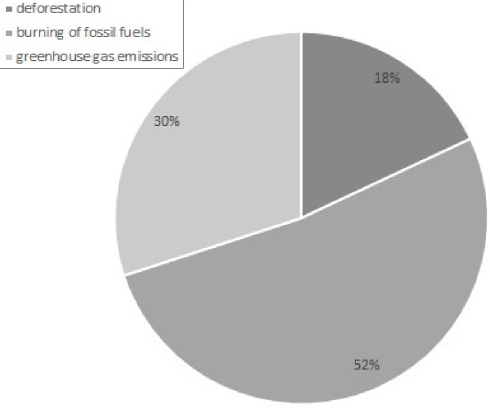
Figure 4. Causes of climate change mentioned during the survey of Wantok Moana members ( n =